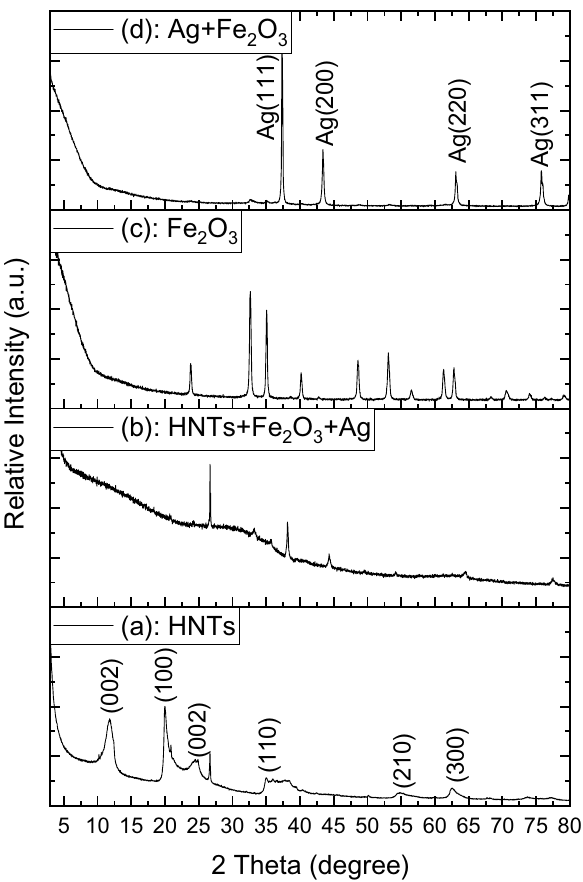
Figure 2. XRD spectra of raw HNTs ( a ), HNTs + Fe 2 O 3 + Ag ( b ), Fe 2 O 3 ( c ) and Fe 2 O 3 + Ag nanocomposites ( d